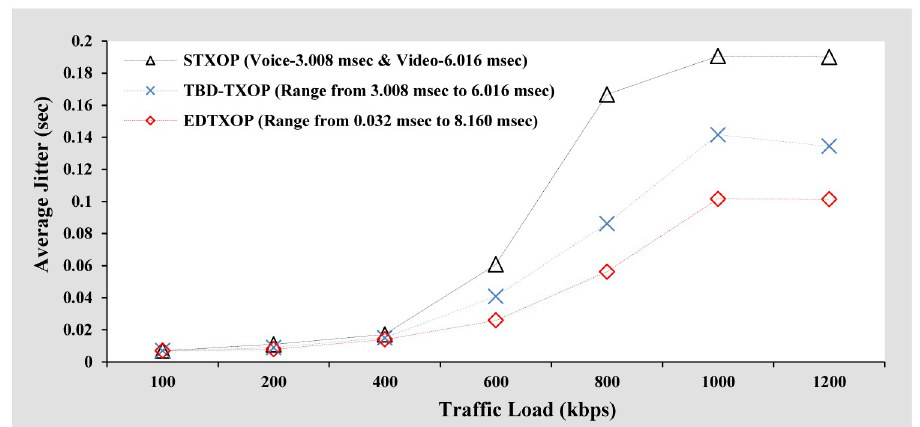
Fig 7. Average jitter analysis based on increasing packet size.